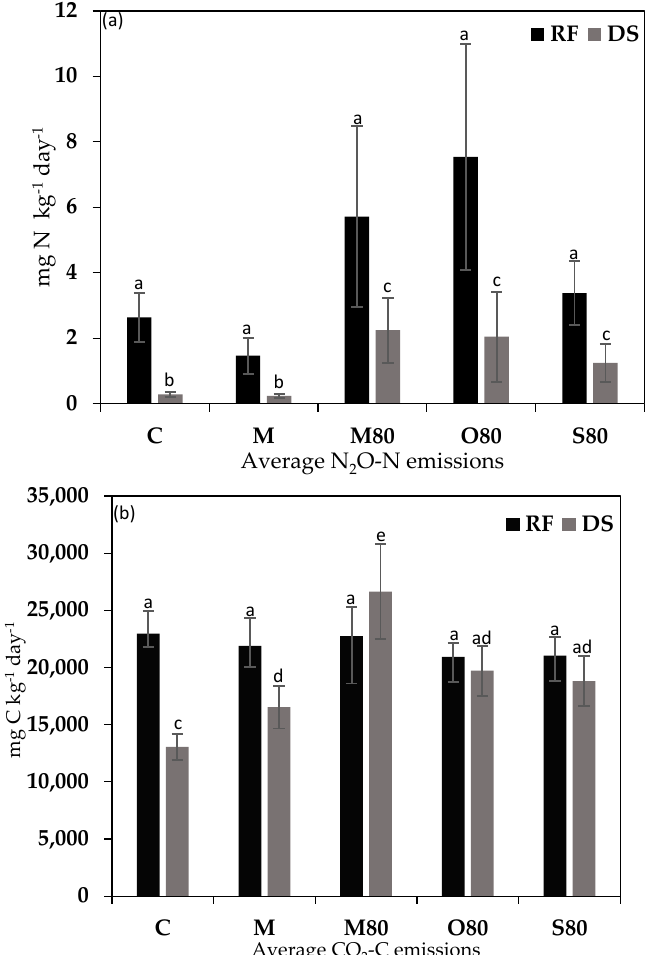
Figure A1. Mean (n = 3) daily emissions of ( a ) N 2 O and ( b ) CO 2 from four cropping treatments on Rainforest, RF , and Dry Savanna, DS , soils averaged over the 21 days. C = control, M = manure only treatment, M80 = Manure + 80 kg N / ha, O80 = No manure + 80 kg N / ha S80 = soil pot microdosed with 80 kg N / ha without any vegetables.